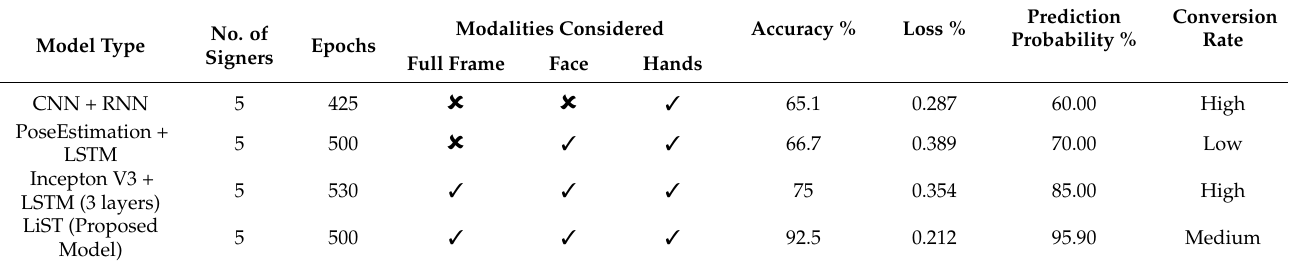
Table 3. Performance comparison of different models trained using the INCLUDE dataset.